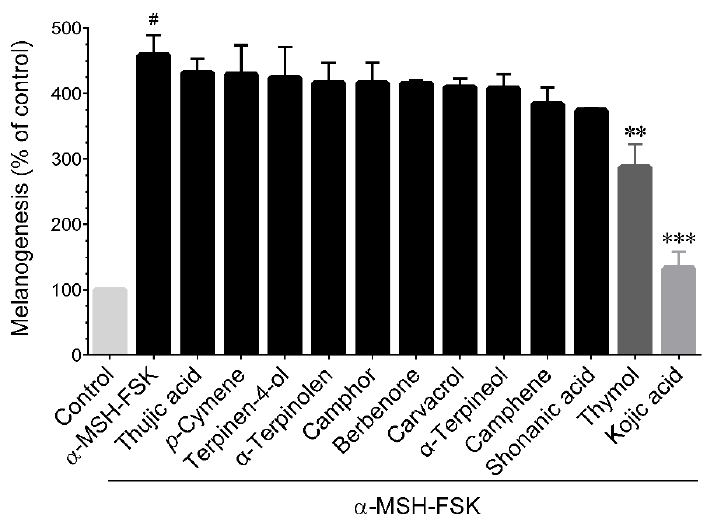
Figure 5. Effect of major compounds from CFEO on α -MSH-FSK-induced melanin production in B16-F10 cells. Cells were incubated with 200 µM of indicated compounds or 1400 µM KA and induced with α -MSH-FSK for 72 h. The cellular melanin content was determined by colorimetric assay. Data represent the mean ± SD of three independent experiments. Statistical significance between control vs. α -MSH-FSK group was set as # p < 0.01. Significance between sample treatment groups vs. α -MSH-FSK treatment group were set as ** p < 0.01 and *** p < 0.001.